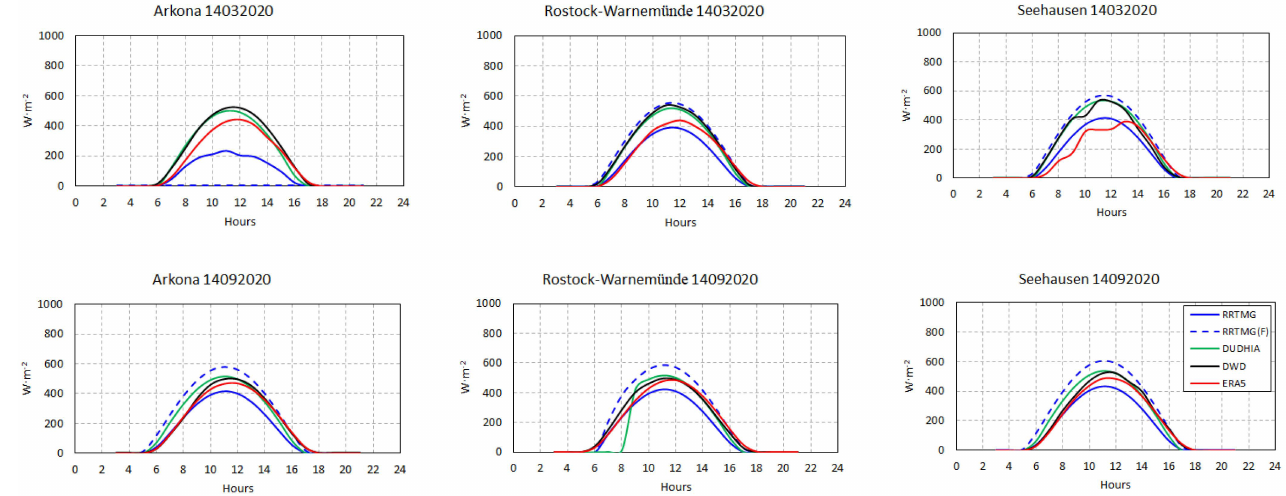
Figure 8. Diurnal distribution of the direct radiation values for the high situations.